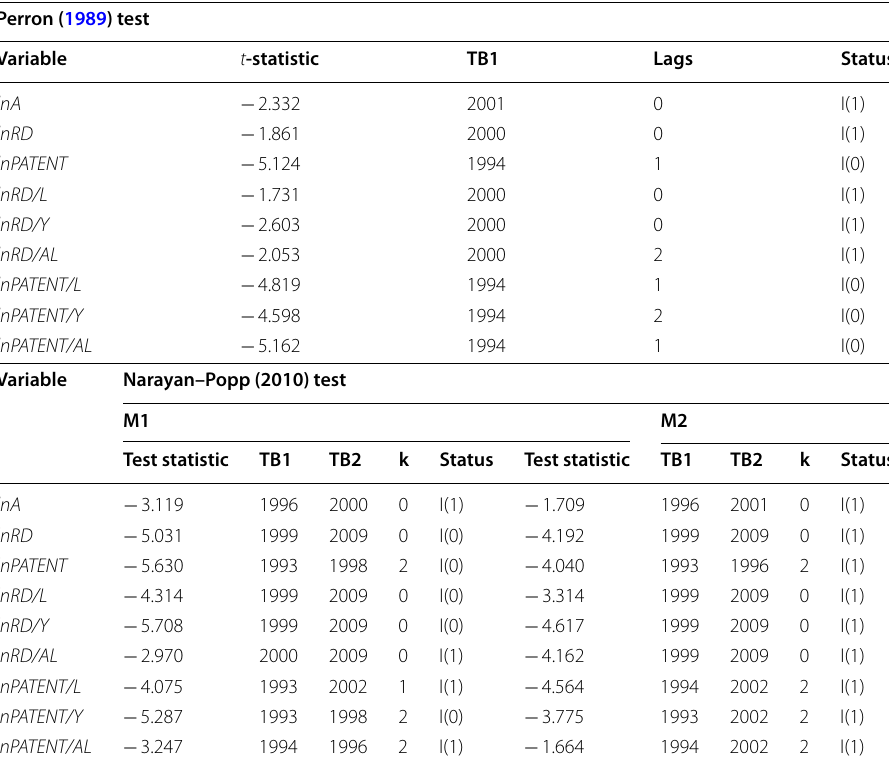
Table 1 Stationarity